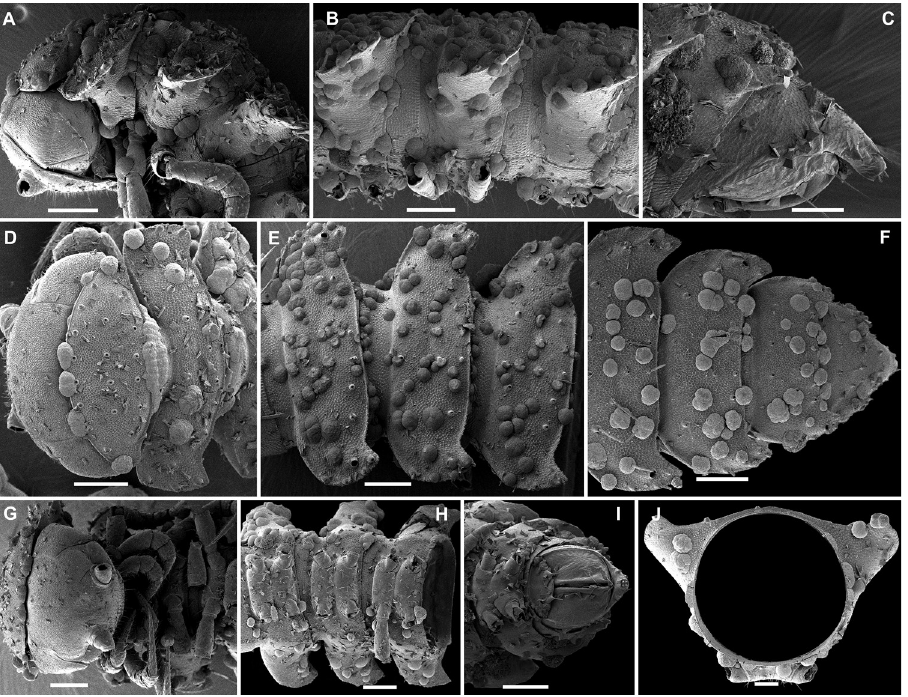
Figure 15. Hemisphaeroparia fusca sp. n., SEM micrographs of ♂ paratype A, D, G anterior part of body, lateral, dorsal and ventral views, respectively B, E, H midbody segments, lateral, dorsal and ventral views, respectively C, F, I posterior part of body, lateral, dorsal and ventral views, respectively J midbody segment, caudal view. Scale bars: 0.2 mm ( A, B, D–I ), 0.1 mm ( C, J